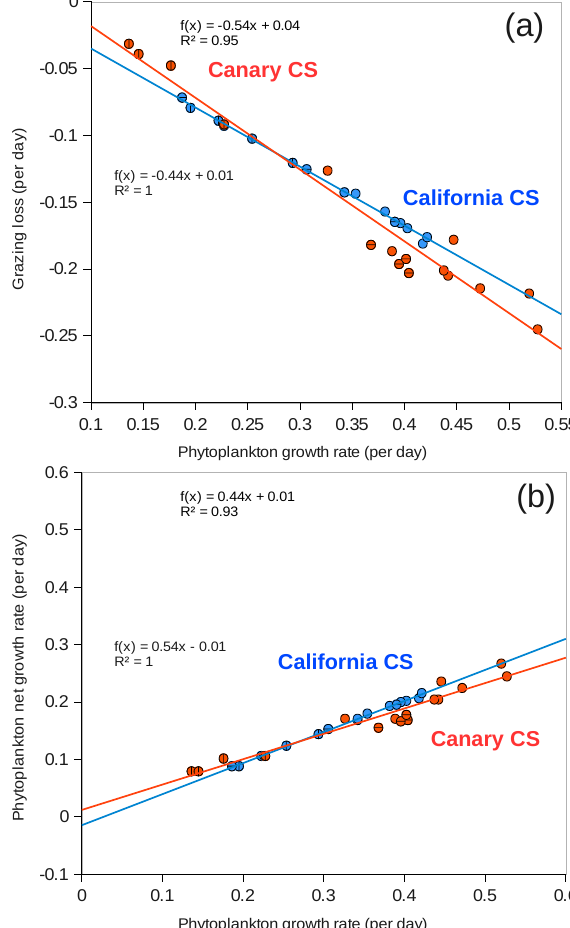
Fig. 9. (a) The grazing rate as a function of the growth rate in the California CS (blue) and Canary CS (orange). (b) The net growth rate as a function of the growth rate in the California CS (blue) and Canary CS (orange). Data were averaged over the 300km wide nearshore area and over 1 ◦ bins in meridional direction. Circles with horizontal lines correspond to the southernmost part of each system, i.e., from 30 ◦ N to 34 ◦ N for the California CS and from 12 ◦ N to 16 ◦ N for the Canary CS, and circles with vertical lines indicate their northernmost parts, i.e., from 42 ◦ N to 46 ◦ N for the California CS and from 24 ◦ N to 28 ◦ N for the Canary